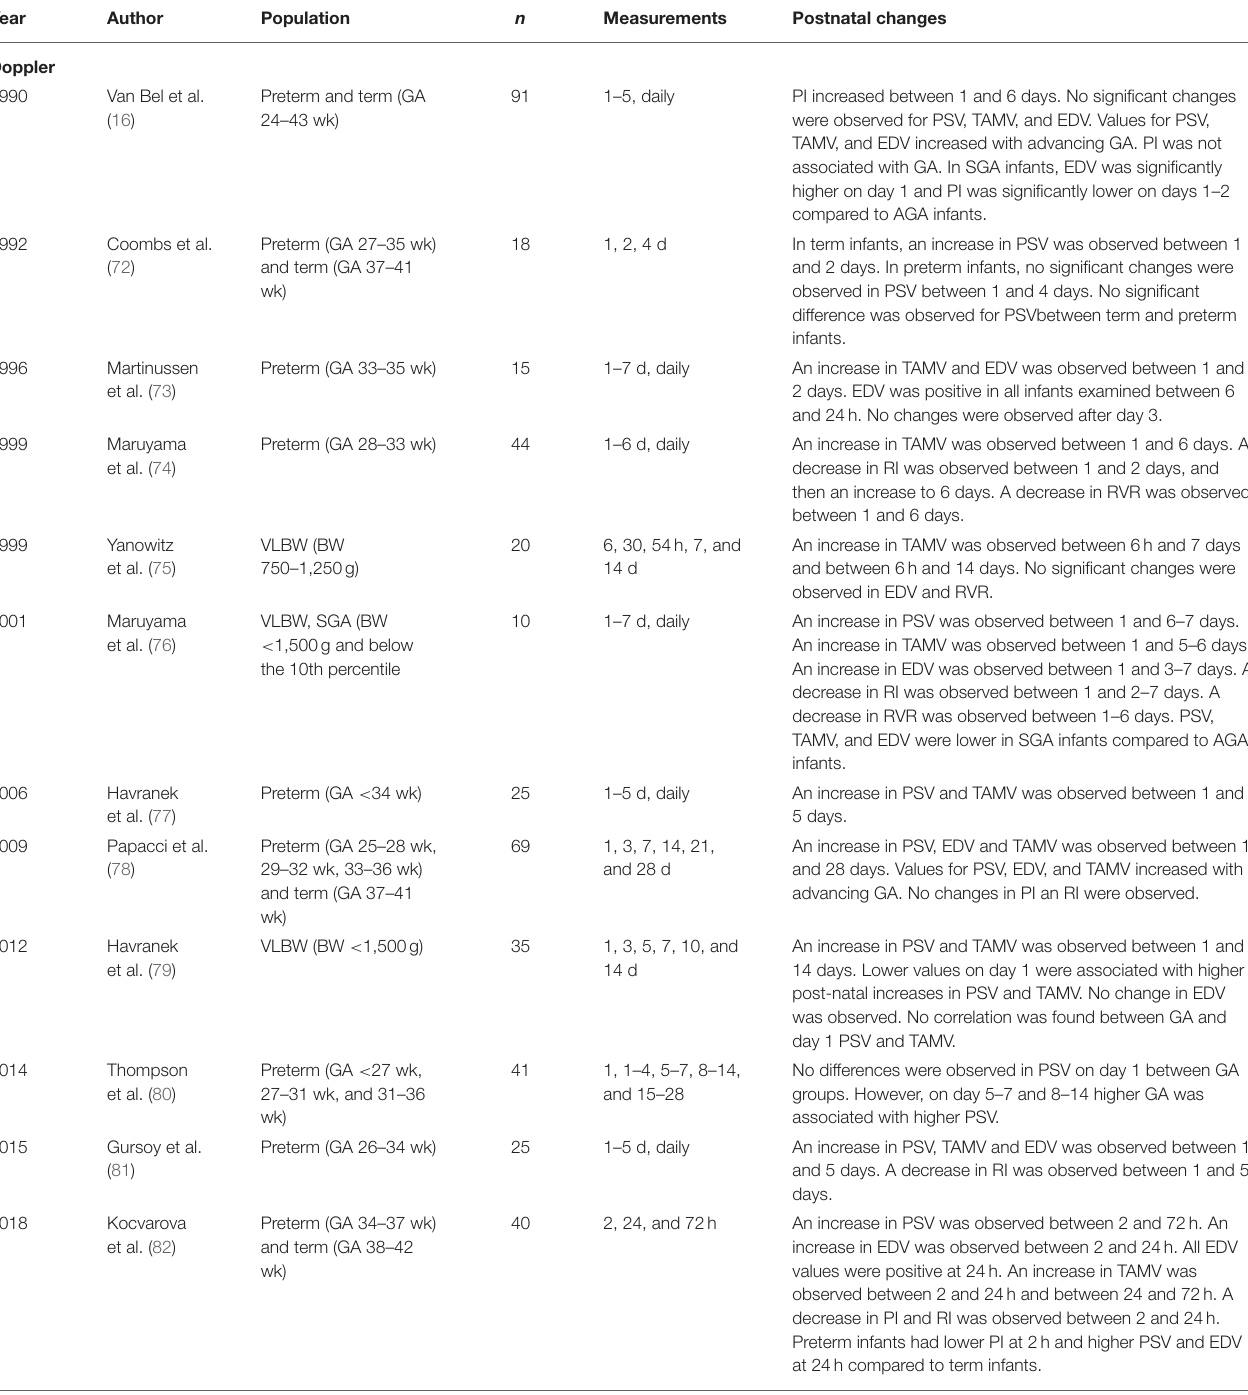
TABLE 3 | Clinical studies in preterm